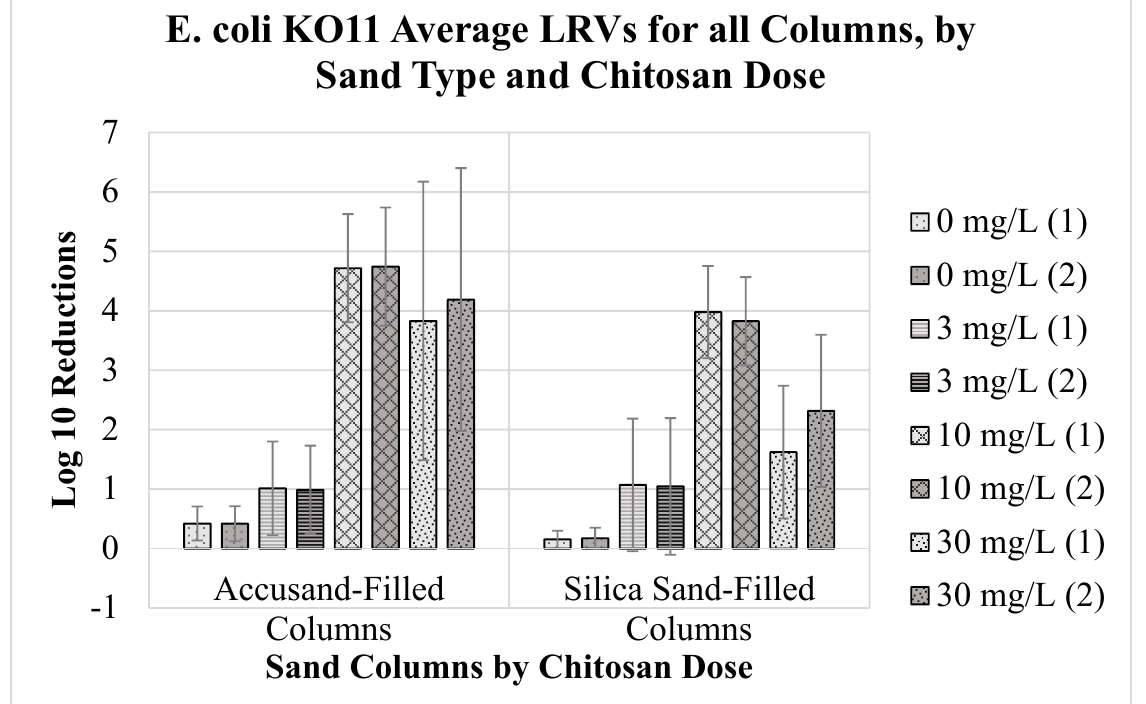
Figure 1. Average log 10 reduction values (LRVs) with standard deviation error bars for E. coli KO11 in water treated by chitosan coagulation followed by Accusand and silica sand column filtration, based on 17 successive samples collected throughout the 57-day experiment period.